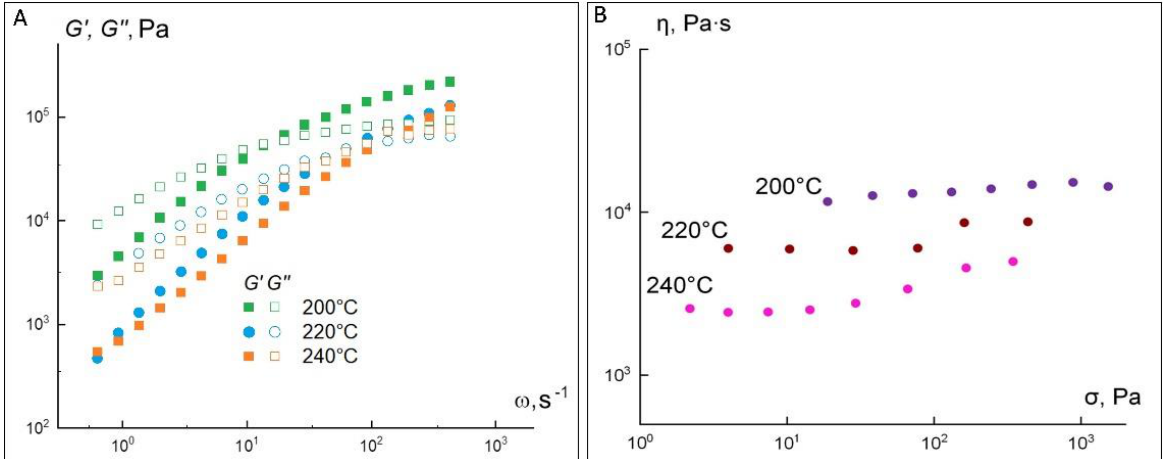
Figure 8. Frequency dependences of elastic and loss moduli ( A ) and viscosity versus shear stress for the 50Al 2 O 3 composition at different temperatures ( B ).